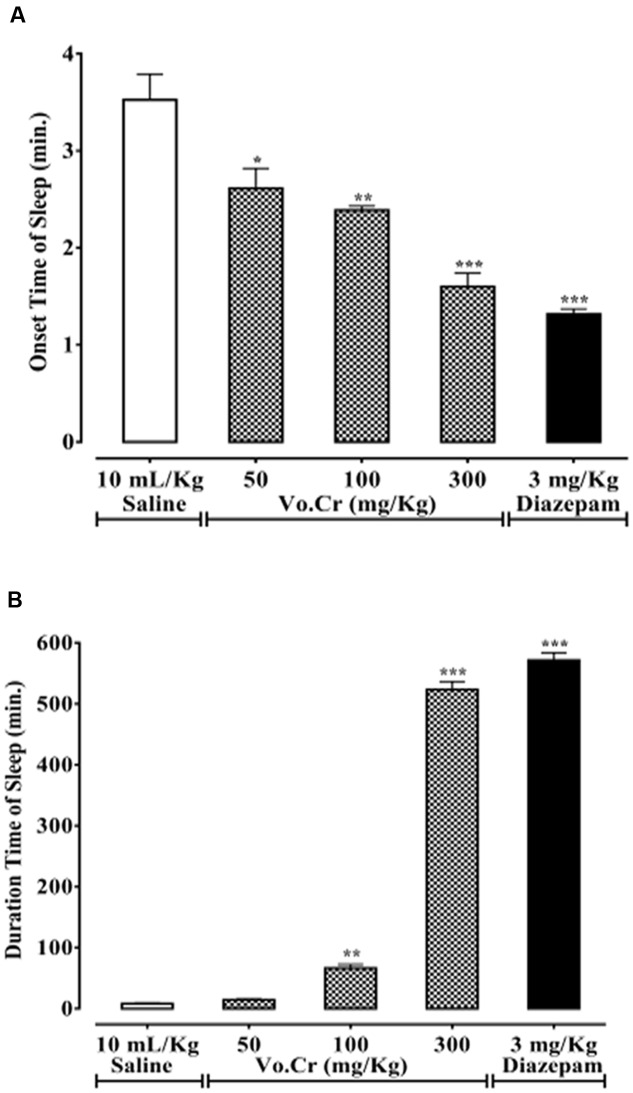
Bar-graph showing effects of Verbena officinalis crude extract (Vo.Cr) and diazepam on
(A) onset time of sleep and (B) duration of sleep in thiopental-induced sleeping test in mice. Data expressed as mean ± SEM, n = 4. ∗P < 0.05, ∗∗P < 0.01, ∗∗∗P < 0.001 vs. saline group, one-way ANOVA with post hoc Tukey test.